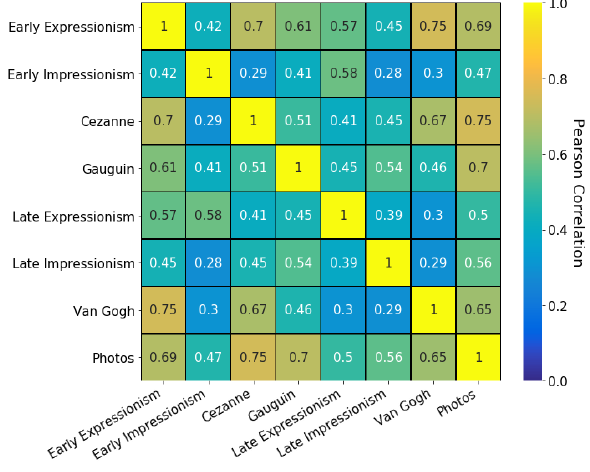
Figure 14. Correlation matrix of Pearson correlations